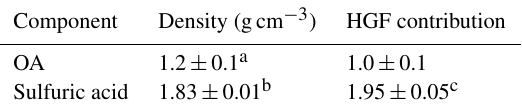
Table 1. Parameters used in the compositional model of marine semi-volatile hygroscopicity.